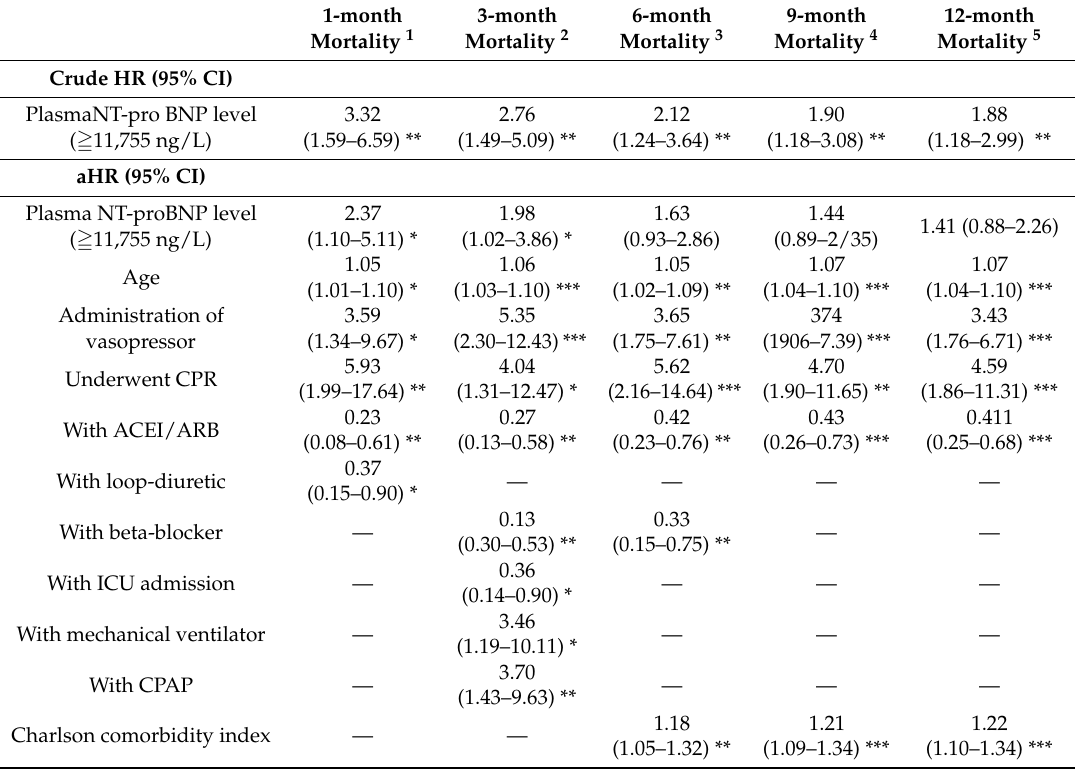
Table 3. Comparisons of independent predictors for mortality with various follow-up